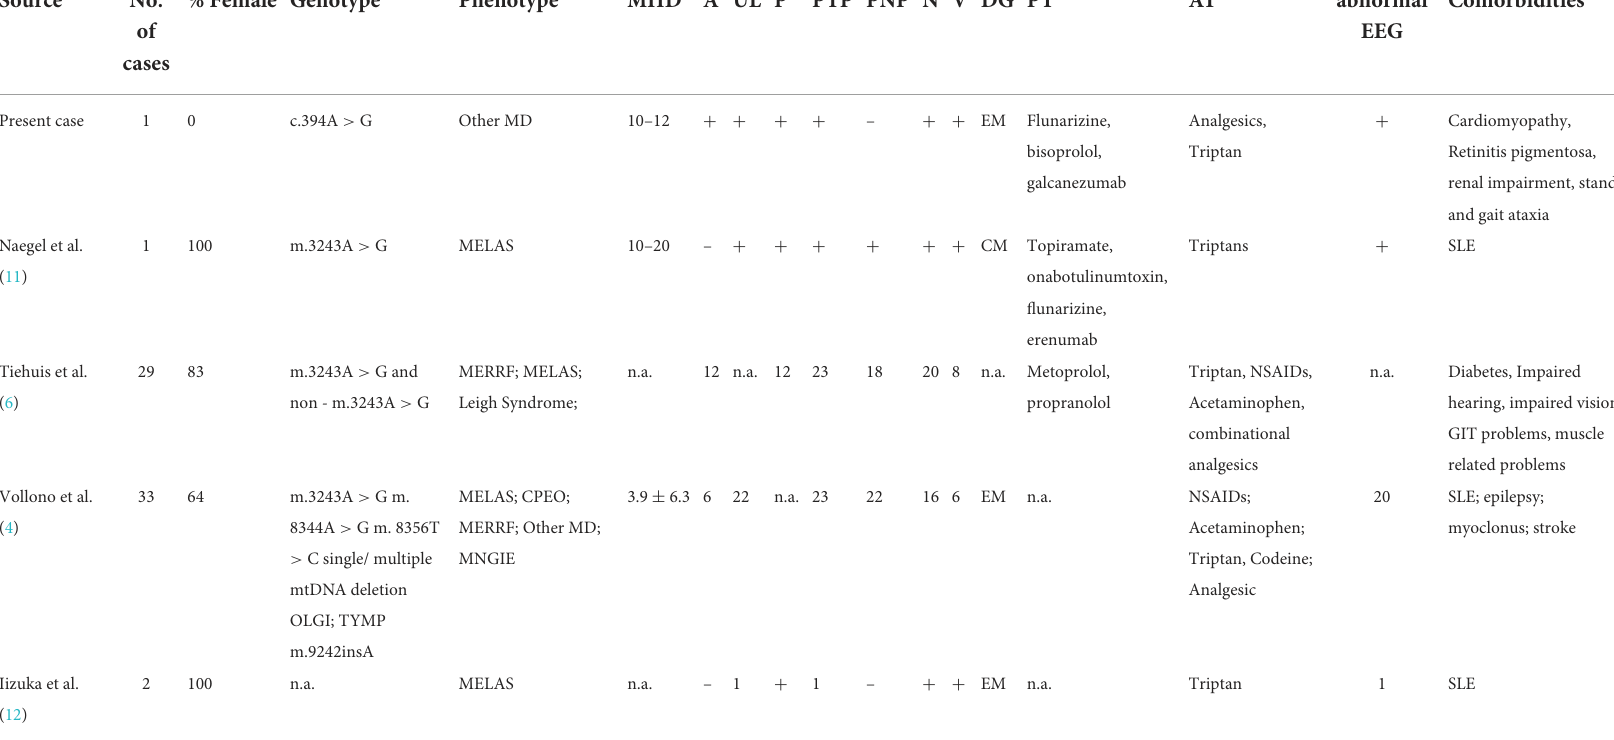
TABLE 1 An overview of the reports on the use of acute or prophylactic migraine treatment in patients with a mitochondrial disorder and their clinical symptoms.